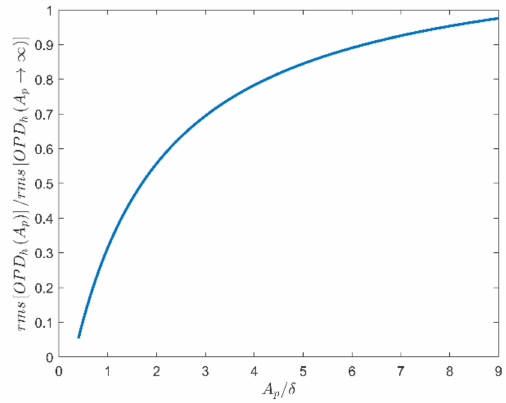
Figure 18. The aperture effects of the blurring component in the OPD.